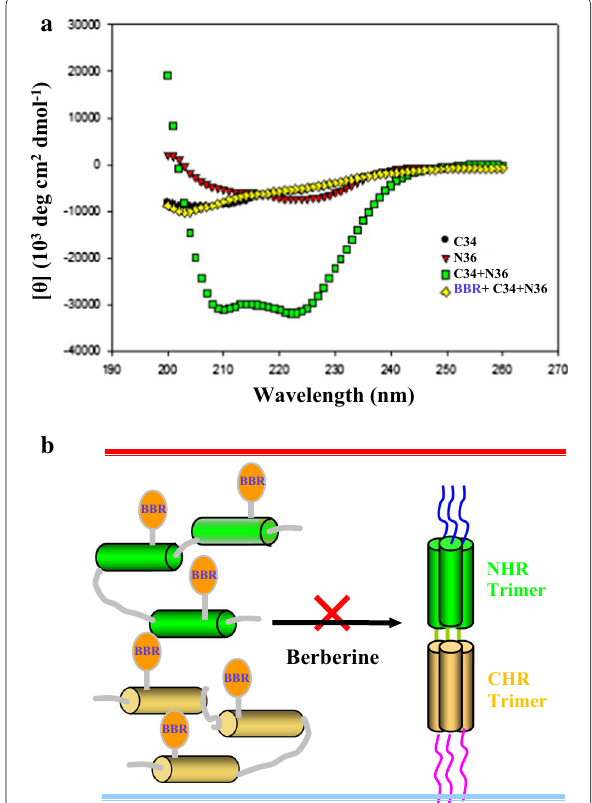
Fig. 4 Effect of berberine on the secondary structure of 6-HB structure by CD spectroscopy. a The secondary structure of 6-HB in the absence of berberine displayed a typical helical conformation, while lost α-helical conformation in the presence of berberine. N36 and C34 served as negative controls, C34 N36 served as a + positive control. The molar ratio of N36 and C34 in a sample was 1:1. b Model of interaction of berberine with NHR and CHR helices of gp41. NHR and CHR helices were indicated in light green and orange, respectively. Berberine was abbreviated to acronyms